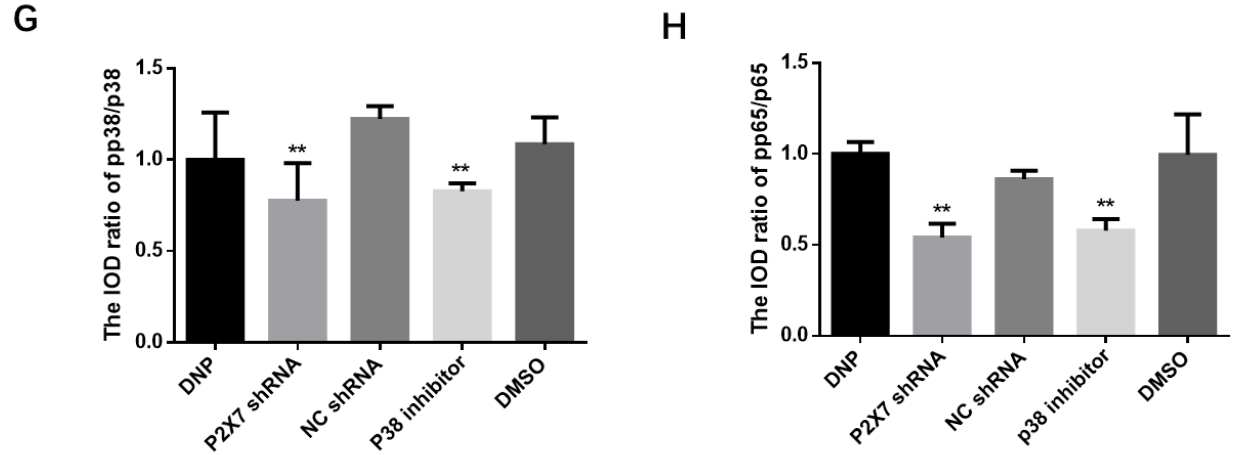
Figure 6. Expression of the PKC ε /P38 MAPK/NF- κ B pathway and inflammatory factors after activation. SDS-PAGE and relative protein expression of TNF- α ( A , B ) and IL-1 β ( C , D ) in DRG. ( E ) SDS-PAGE of PKC ε , p38, pp38, p65 and pp65 in DRG. Statistics of ( F ) PKC ε / β -actin ( G ) pp38/p38 ( H ) pp65/p65; data are shown as mean ± SEM based on at least three independent experiments, n = 6; ** p ≤ 0.01 versus the DNP group.